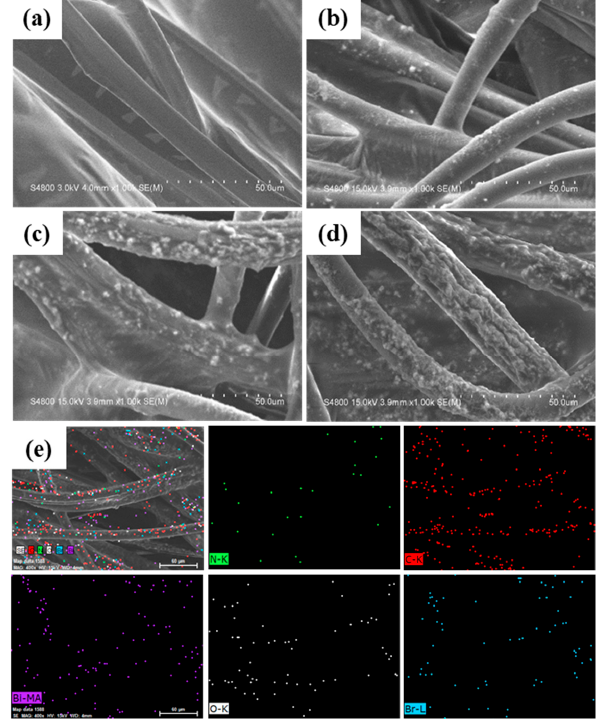
Figure 9. FESEM images of polymer-modified gauze ( a ) P, and polymer/BiOBr-modified gauze samples prepared by changing the time for spray coating (10, 20, 30 s) ( b ) PB10, ( c ) PB20, ( d ) PB30, and ( e ) elemental N, C, Bi, O, Br mapping images of PB30.